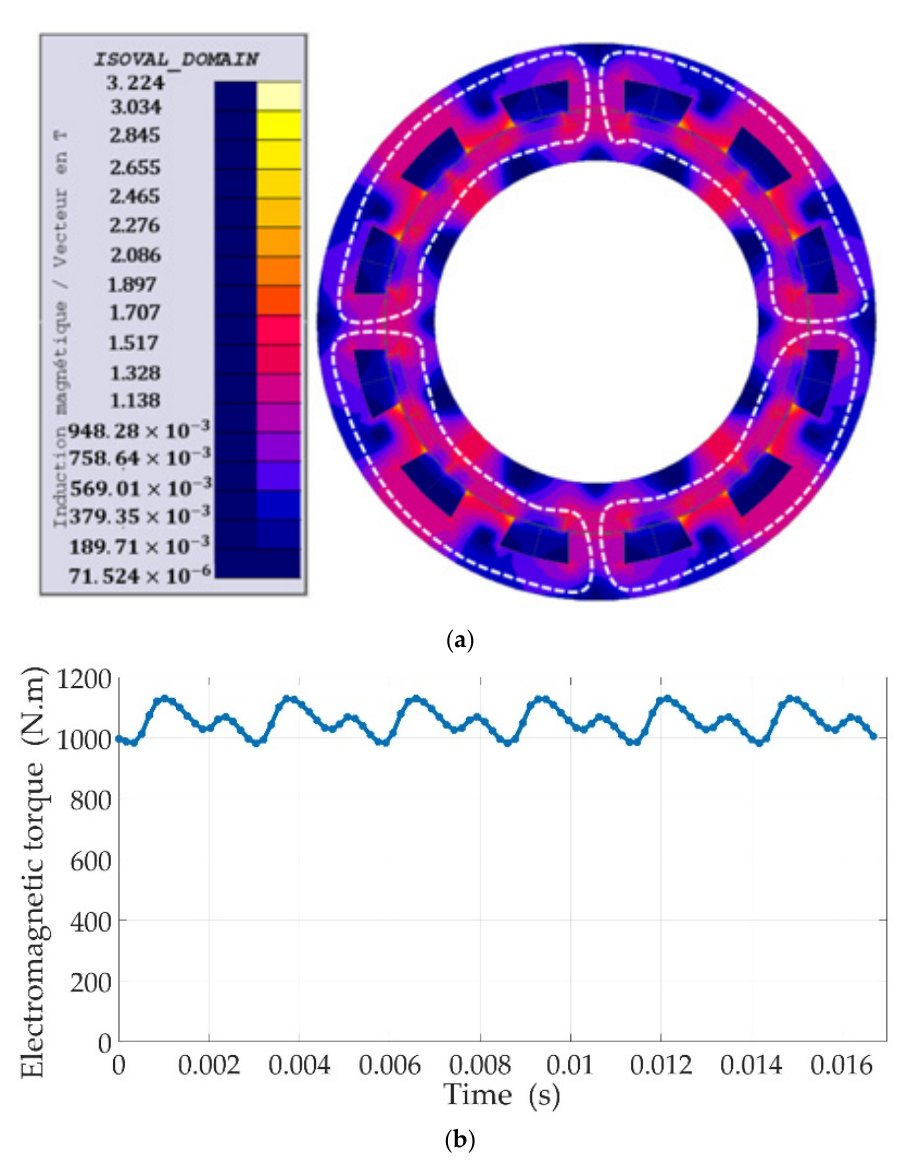
Figure 7. No-load magnetic field density in the cross-section of the initial prototype ( a ) and electro- magnetic torque vs. time ( b ).